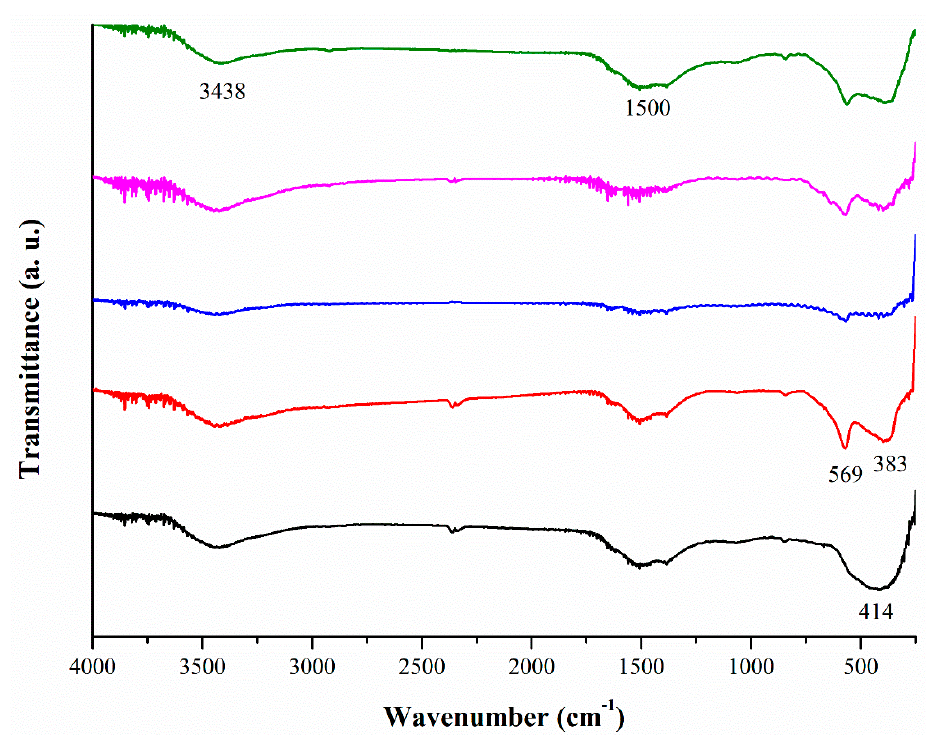
Figure 9. IR spectra (KBr) of samples calcined at 550 ◦ C: Fe 3 O 4 / 1.5CeO 2 (green line); Figure 3 red line); Fe 3 O 4 :PVP / 1.5CeO 2 (blue line); Fe 3 O 4 :OA / 1.5CeO 2 (magenta line); 1.5CeO 2 (black line).